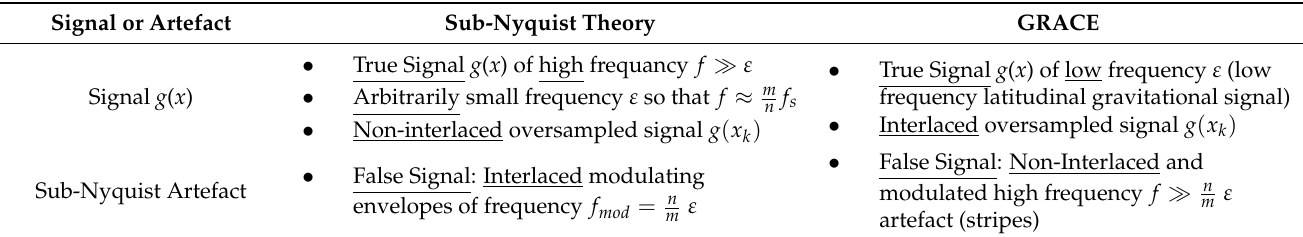
Table 1. Relationship between classical sub-Nyquist theory and GRACE signals. Signal or Artefact Signal g ( x